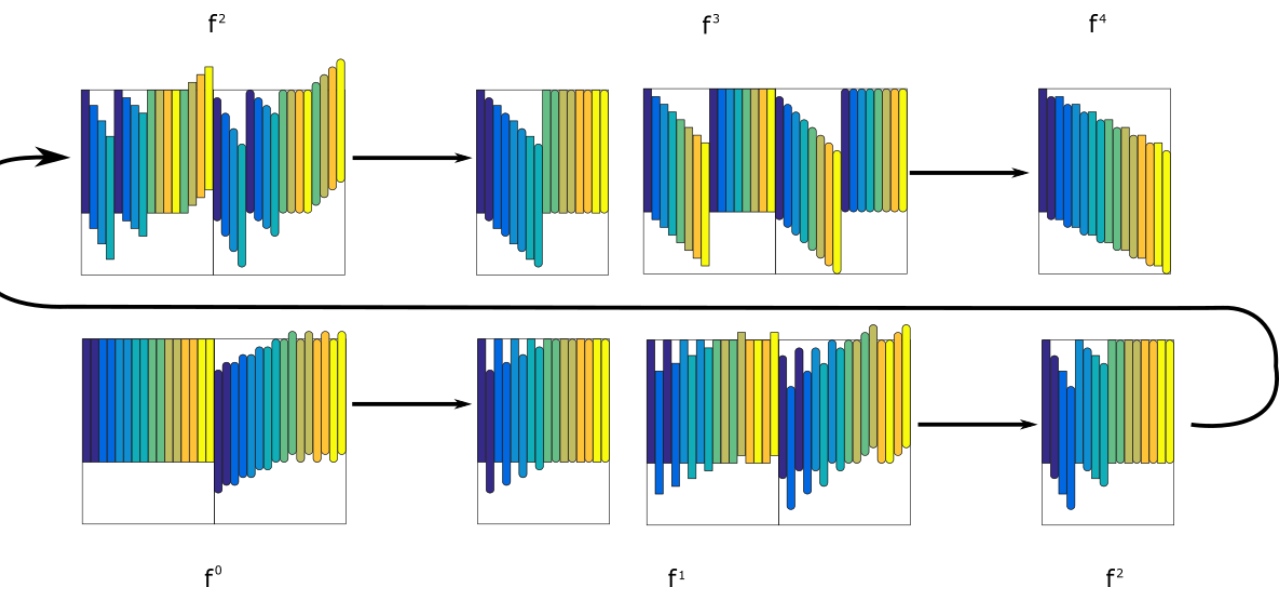
Figure 12. N-length vectors lying on different columns to be added at each stage of the algorithm for a 16 × 16